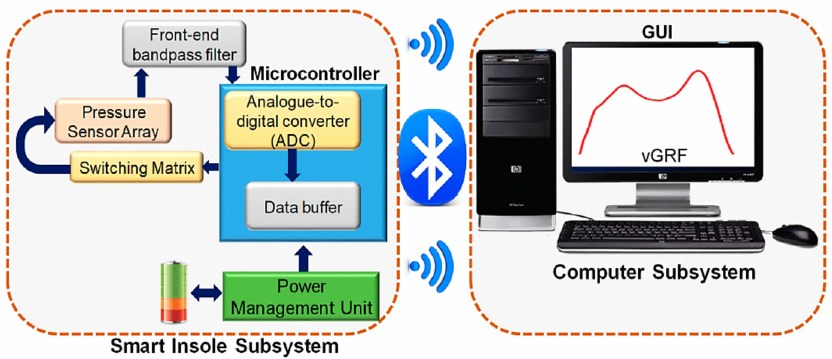
Figure 1. Overall block diagram of the insole data acquisition system, Adapted from Ref.